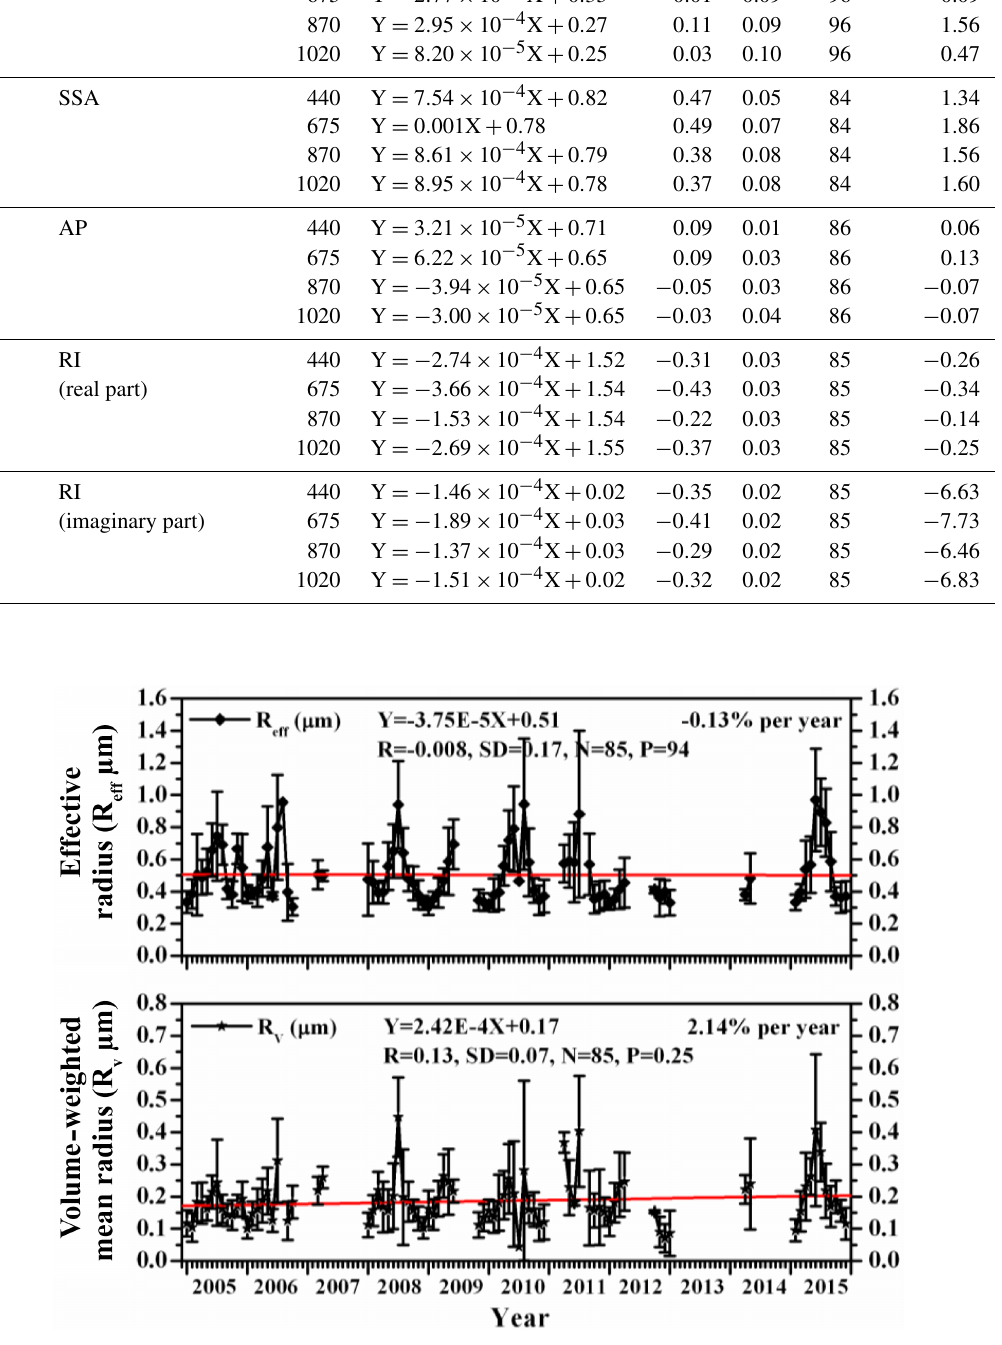
Figure 10. Long-term monthly mean variation of effective radius ( R eff µm) and volume-weighted mean radius ( R v µm). The vertical bar at each data point represents the standard deviation from the